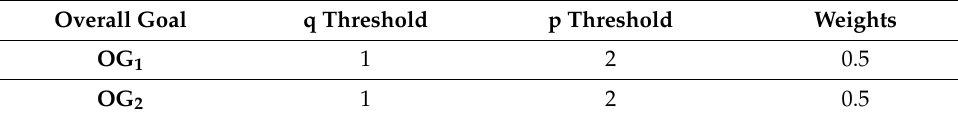
Table A3. Expert’s specification of the goals’ thresholds and weights.